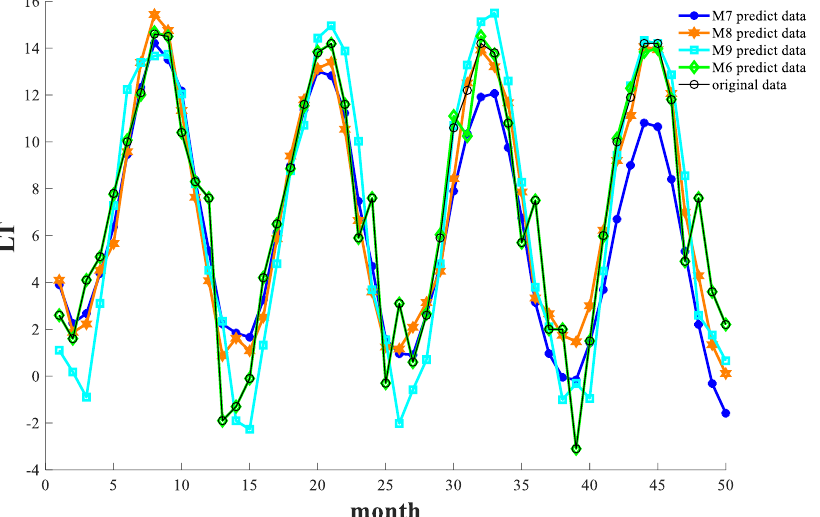
Figure 20. Predicting effect of the observed and predicted lowest temperature (unit: °C) using M6 − M9 models.